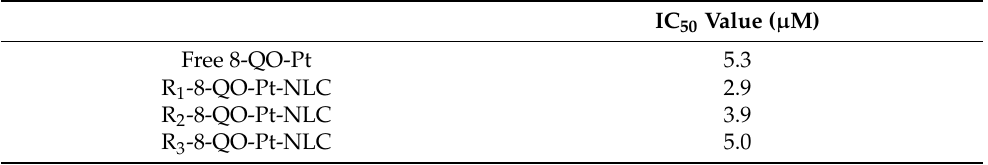
Table 3. IC 50 values ( µ M) of free 8-QO-Pt and the formulations after 24 h of incubation.